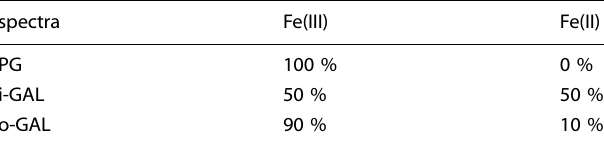
Table 4. Valence of iron at nanometer scale (±2) in pristine glass, i-GAL and o-GAL obtained with linear regression on Fe L-edge